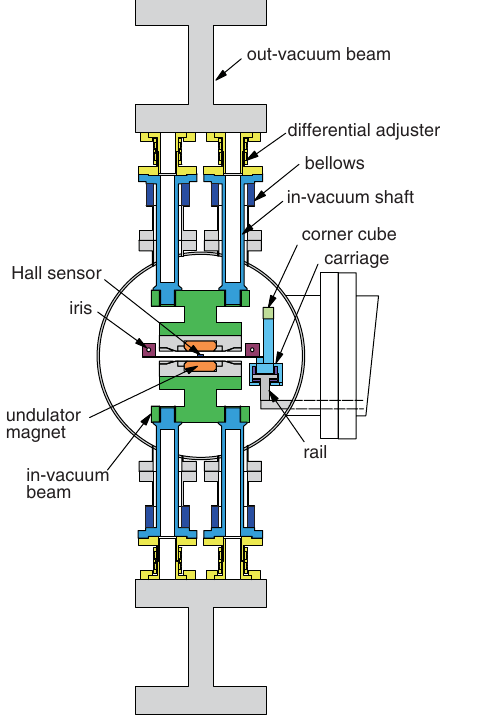
FIG. 4. (Color) Cross-sectional view taken along the line A - A 0 of Fig.